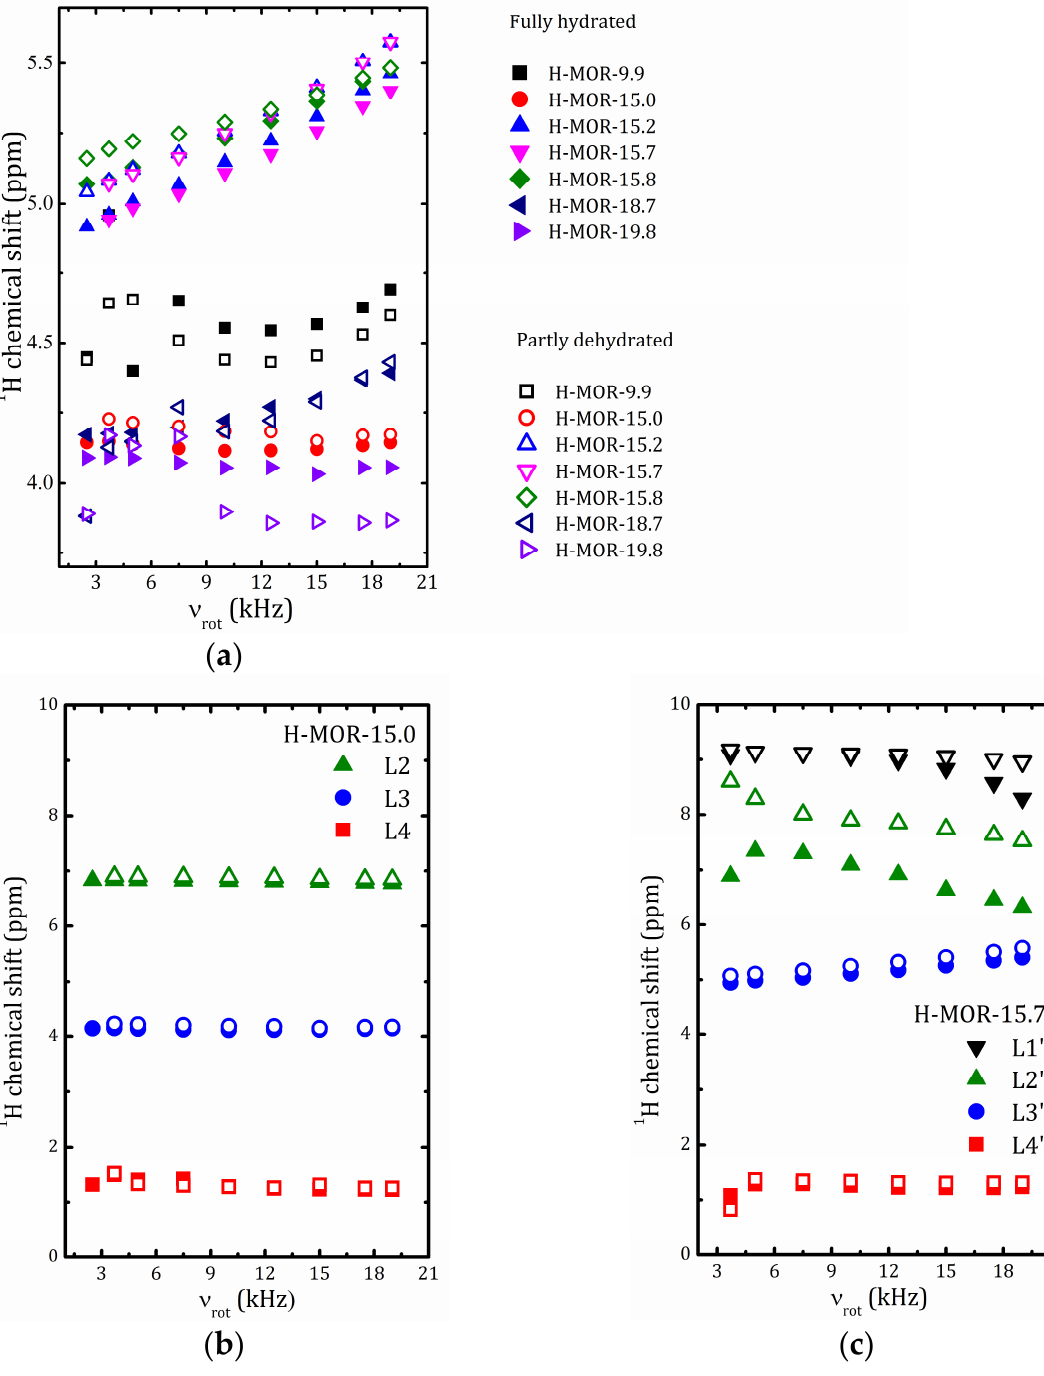
Figure 6. 1 H NMR chemical shift of individual spectral lines at different rotor frequencies: ( a )—L3 (L3 ′ ) line in all the samples; ( b )—L2, L3, L4 for H ‐ MOR ‐ 15.0; ( c )—L1 ′ , L2 ′ , L3 ′ and L4 ′ for H ‐ MOR ‐ 15.7. Solid and open symbols correspond to the fully hydrated and partly dehydrated samples.